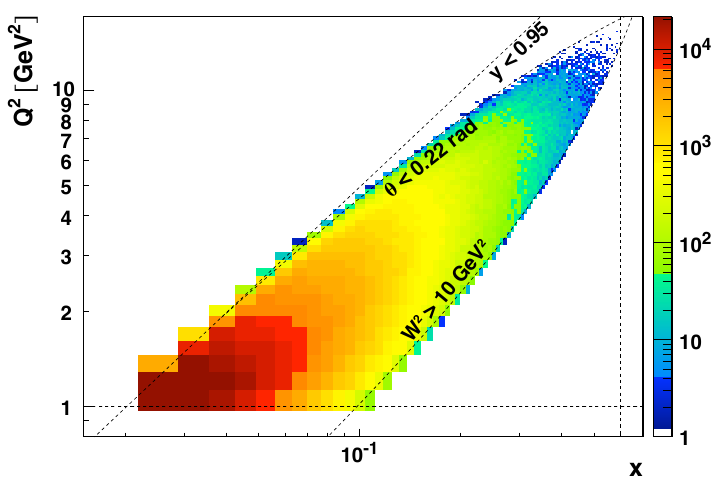
Figure 3 . Event distribution in the kinematic space in ( x , Q 2 ), including the various boundaries arising from constraints on x , y , Q 2 , W 2 , and the upper reach in the lepton scattering angle θ